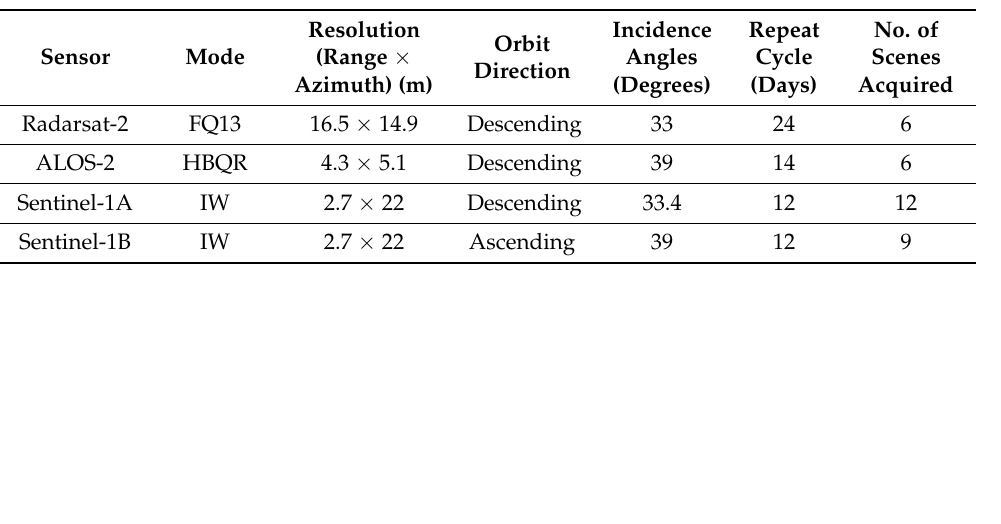
Figure 1. Upper left: map of study area showing the Arctic and Cambridge Bay location (the red triangle). Lower left: Cambridge Bay study area covered by ALOS-2 HBQR mode (green line) and Radarsat-2 FQ13 mode (purple line). The background is a Sentinel-1 image of IW mode acquired on 25 March 2019. Right: locations of Ice Profiler and InSAR measurements (RP, P1, P2, P3, P4, P5). The background is an example interferogram with clear fringes over the sea ice generated using Sentinel-1 IW mode of HH polarization acquired on 25 March 2019 and 6 April 2019. Table 1. SAR data used for the InSAR